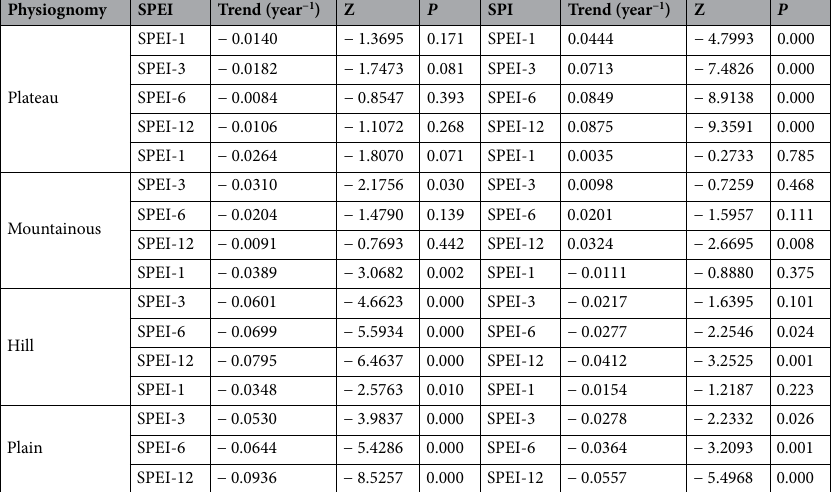
Table 2. MK Trend test coefficient and significance coefficient ( P ) of SPI and SPEI in different geomorphologic types in Sichuan province on different time scales.